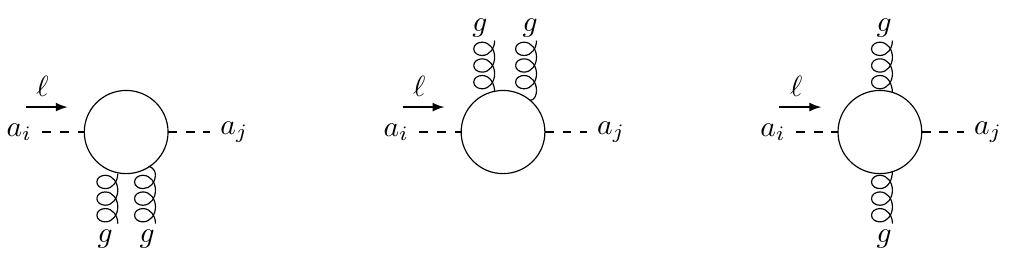
Figure 11 . The diagrams which contribute to the e(cid:11)ective operators a